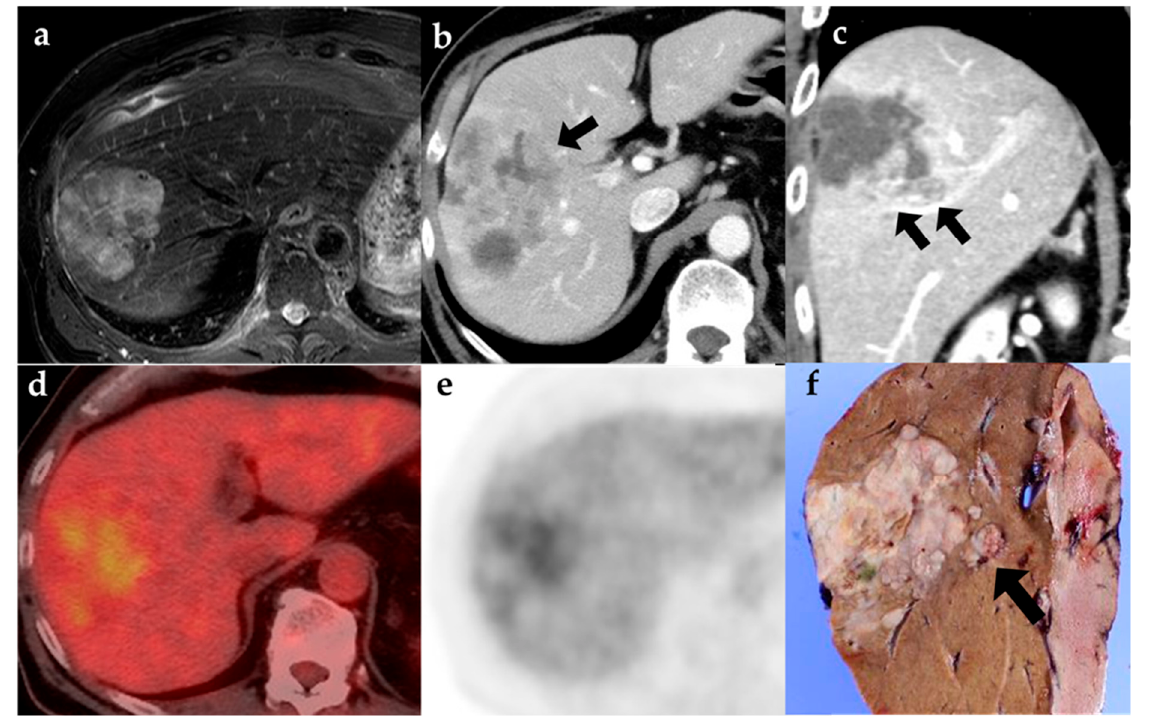
Figure 2. Contrast-enhanced CT showed bile duct (( b ); arrow) and vascular emboli (( c ); arrow), which were not detected on MRI ( a ) or PET-CT ( d , e ). ( a ) T2-weighted MR image, ( b ) Axial section of contrast-enhanced CT, ( c ) Coronal section of contrast-enhanced CT ( d , e ) PET-CT, ( f ) Gross specimen (vascular emboli; arrow).